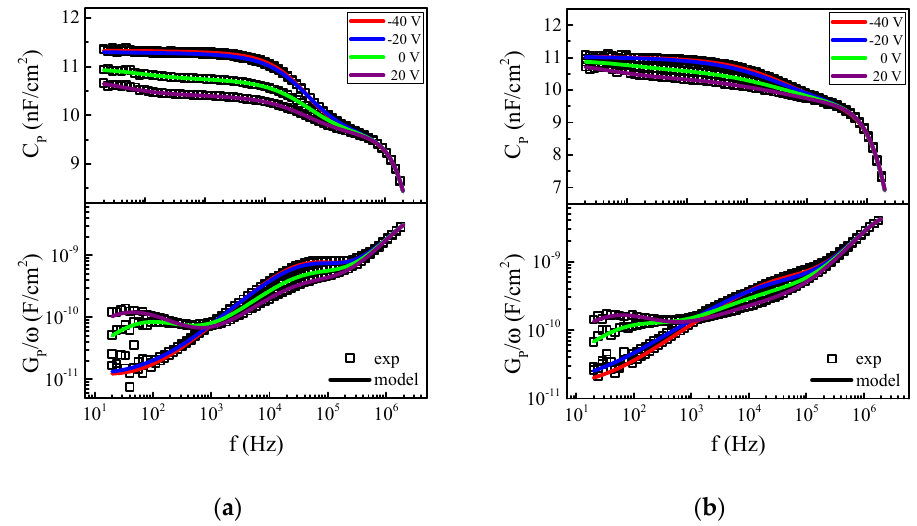
( b ) Figure 7. AFM images (5 µm × 5 µm) of OSC film deposited SiO 2 /HMDS at ( a ) 90 °C and ( b ) 120 °C. Table 2. Model parameters extracted for OTFTs in BG configuration on SiO 2 /HMDS insulator for different substrate temperatures during OSC deposition. Temperature